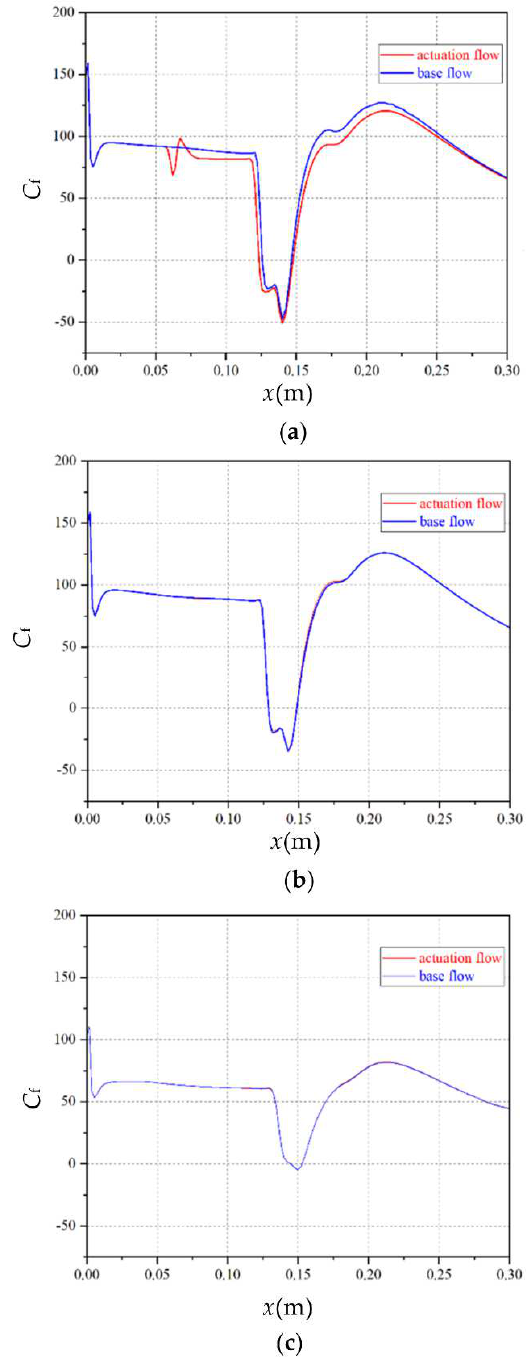
Figure 17. Skin friction coefficient curve at different spanwise cross sections: ( a ) z = 0; ( b ) z = 0.025 m; ( c ) z = 0.054 m.